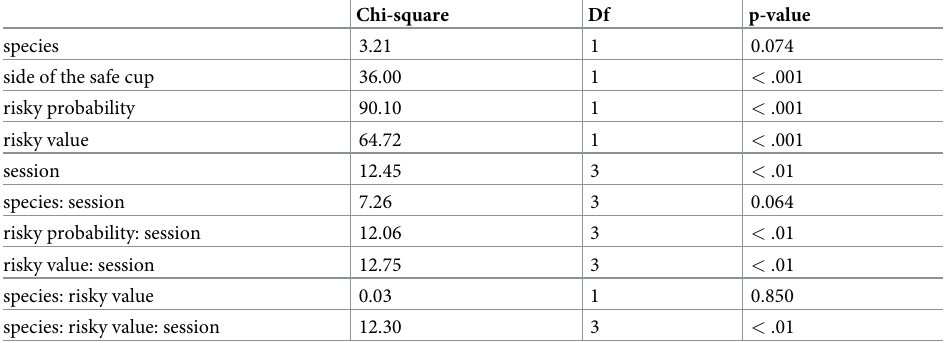
Table 3. Fixed effects of the final model investigating subjects’ risky preference in Experiment 1. The table reports the results of the analysis of deviance (type II Wald chi-square tests).